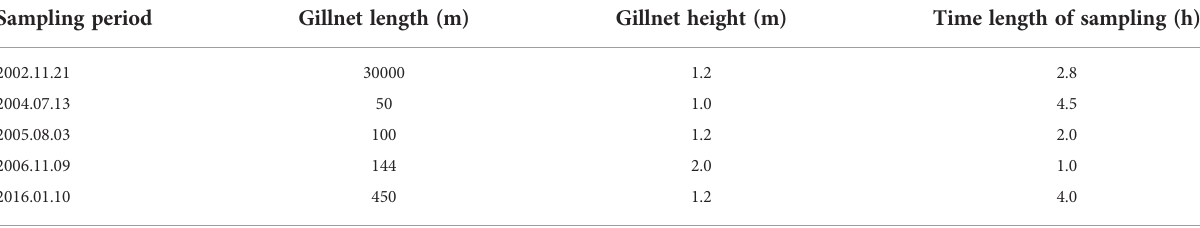
TABLE 2 Parameters of gill net used during sampling